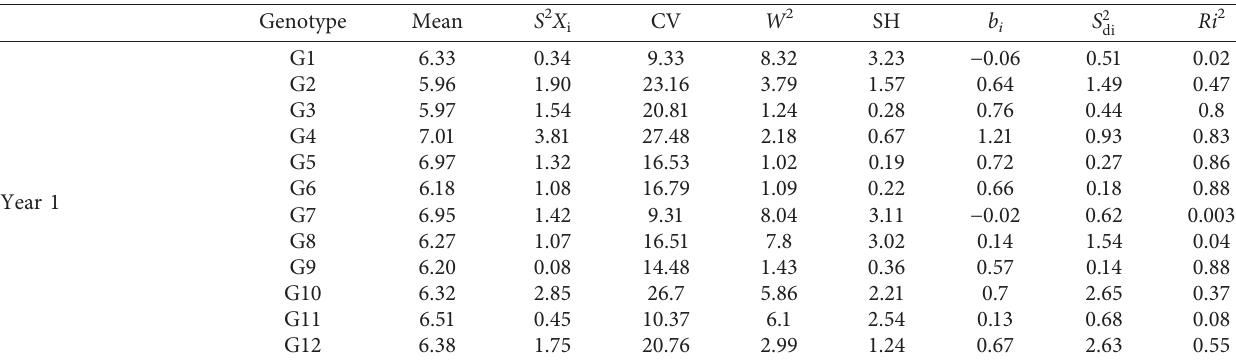
Table 5: Mean gain yield and 8 estimates of parametric stability measures for maize yield across 4 environments in 2